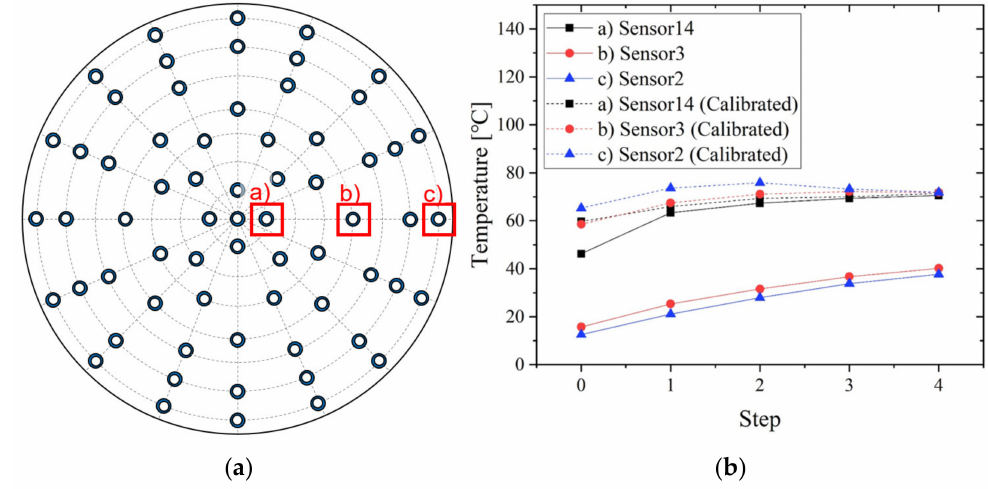
Figure 7. Graphs of before and after temperature calibration that ESC temperature distribution: ( a ) Sensor location of 2nd TMU, 3rd TMU, and 14th TMU and ( b ) graph of before and after